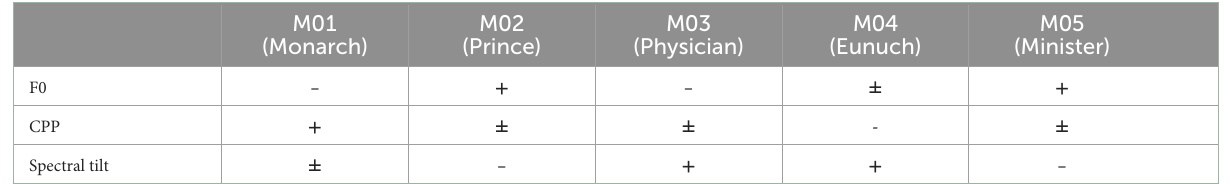
TABLE 4 Distinctive features of the character voice of the five characters.